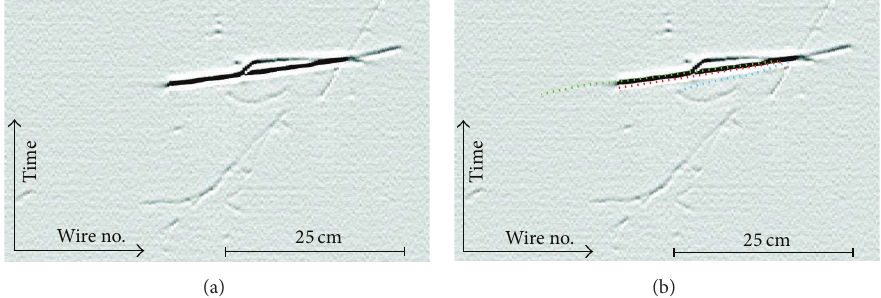
Figure 7: Muon track (data, CNGS ] 𝜇 CC interaction) observed in the Induction1 view and reconstructed using the Collection and the Induction2 plane hits with different delay values between these planes: (a) Induction1 raw data view; (b) 3D track reconstructed with three different delay values and then projected to Induction1 view, orange-optimal delay, blue and green, over- and underestimated delay,